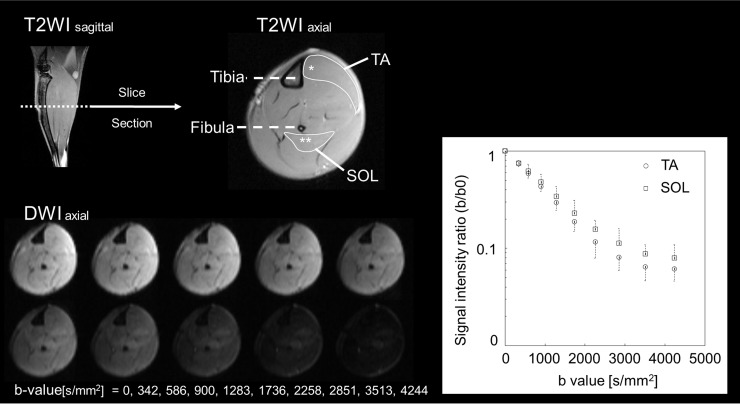
Magnetic resonance imaging (MRI) diffusion raw data.Axial and sagittal T2-weighted MRI scans were performed as reference scans for muscle identification and measurement. The region with the maximum circumferential diameter in the calf is confirmed. Region of interests of tibialis anterior muscle (TA) and soleus muscle (SOL) for MRI analysis were shown in T2-weighted axial image. We identified the muscles in contact with the tibia and fibula as markers and obtained the histologies from the vicinity of these bones. Axial diffusion-weighted image with the largest calf circumference was used. TA: tibialis anterior muscle, SOL: soleus muscle, *: biopsy site of TA, **: biopsy site of SOL.